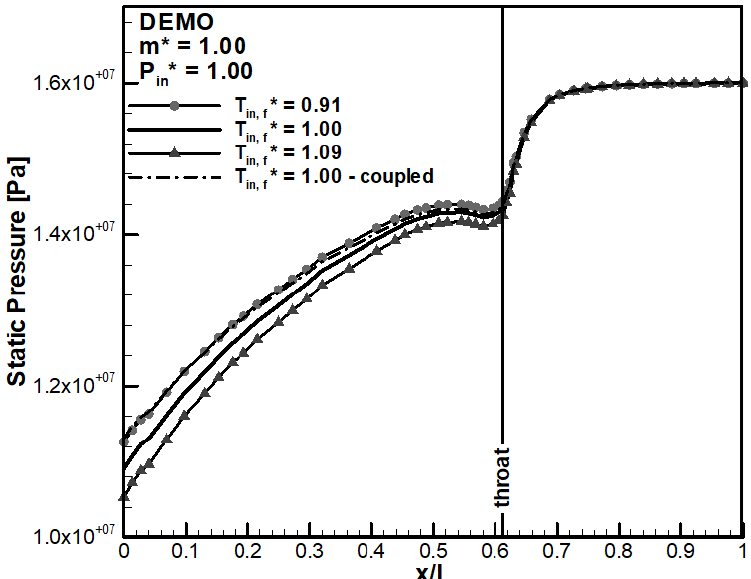
Figure 10. Axial profiles of static pressure, considering different values of inlet fluid temperature (runs 1-4).